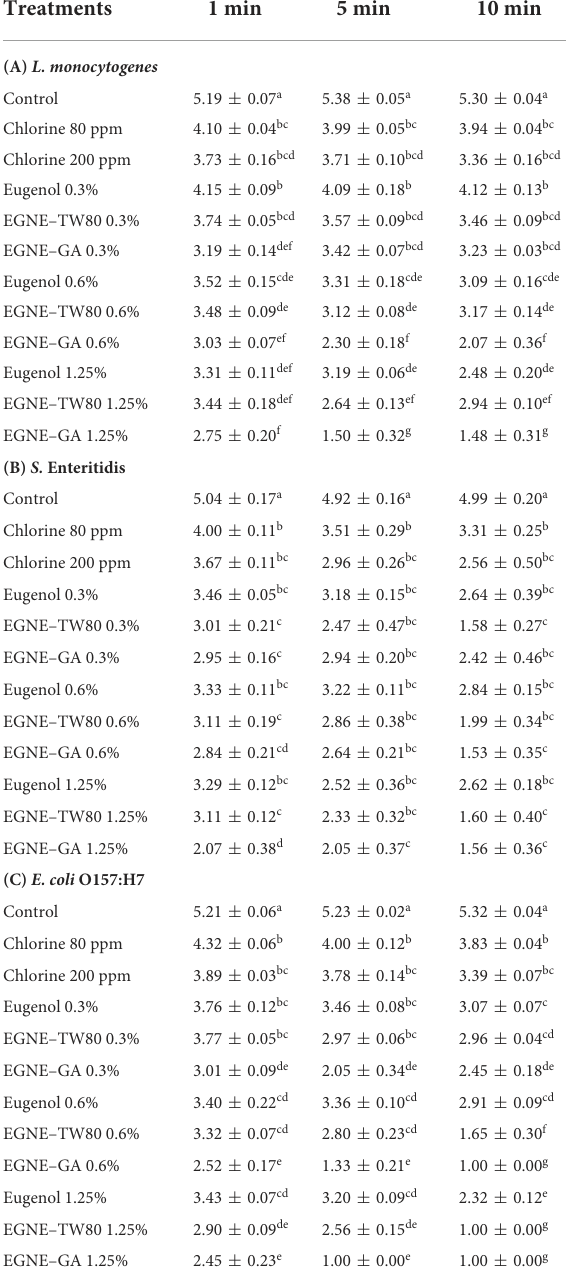
TABLE 3 Inactivation of L. monocytogenes , S. Enteritidis, or E. coli O157:H7 on cantaloupe rind by eugenol or eugenol nanoemulsions wash at 25 ◦